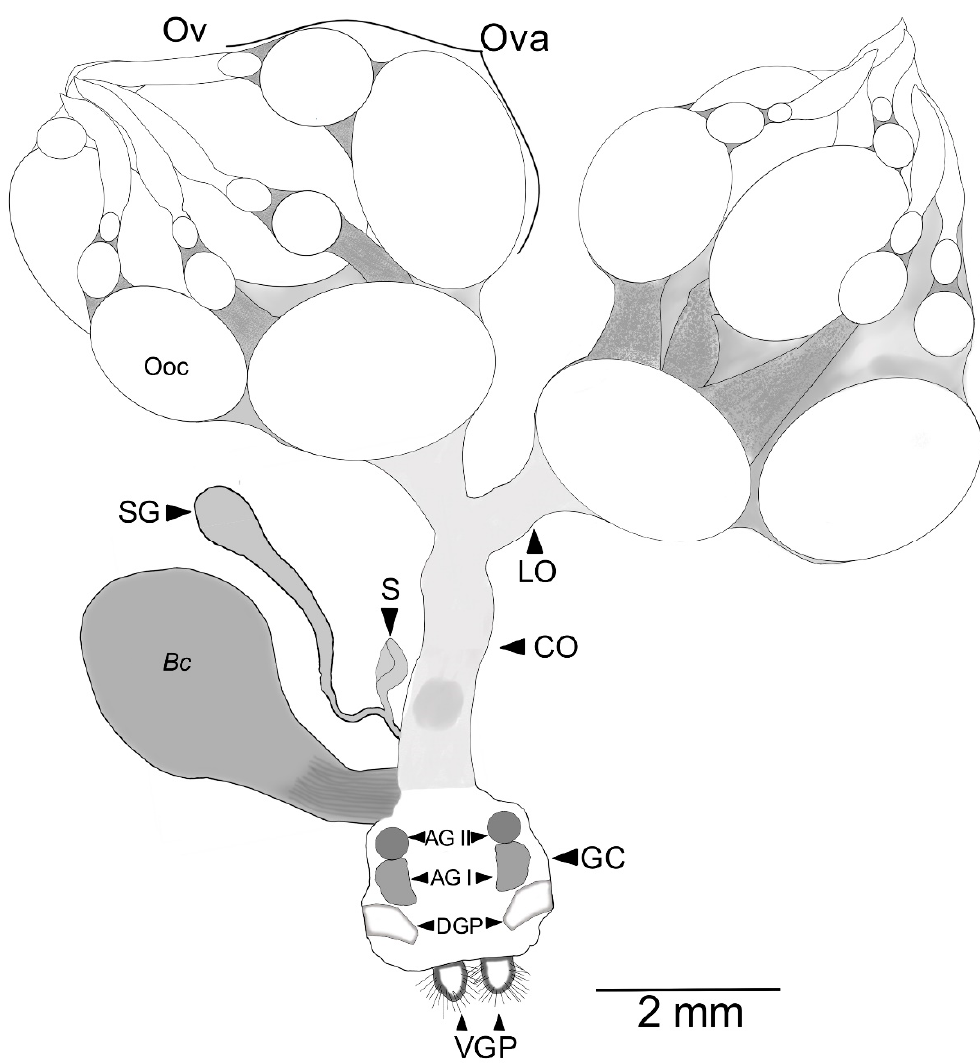
Figure 5. Reproductive apparatus of 18 d old virgin Cyclocephala barrerai female. Bc = bursa copulatrix , GC = genital chamber, S = spermatheca, SG = spermathecal gland, AG I = accessory gland type I, AG II = accessory gland type II, Grm = gremarium, Ooc = oocyte, Ov = ovary, Ova = ovariole, CO = common oviduct, LO = lateral oviduct, DGP = dorsal genital plates, VGP = ventral genital plates.